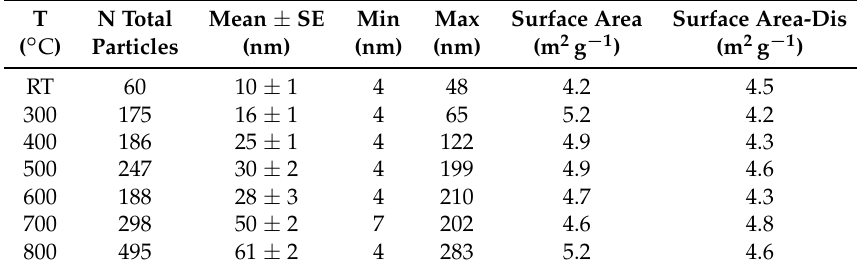
Table 1. Statistics of silver nanoparticle sizes, amount of measured particles (N total) and their standard error (SE). The specific surface area for the SiO 2 -Ag powders heat treated at different temperatures (measurement accuracy ± 5%). The specific surface area determined by nitrogen adsorption-desorption is also presented for the SiO 2 -Ag samples with the surface Ag dissolved by HNO 3 (marked with